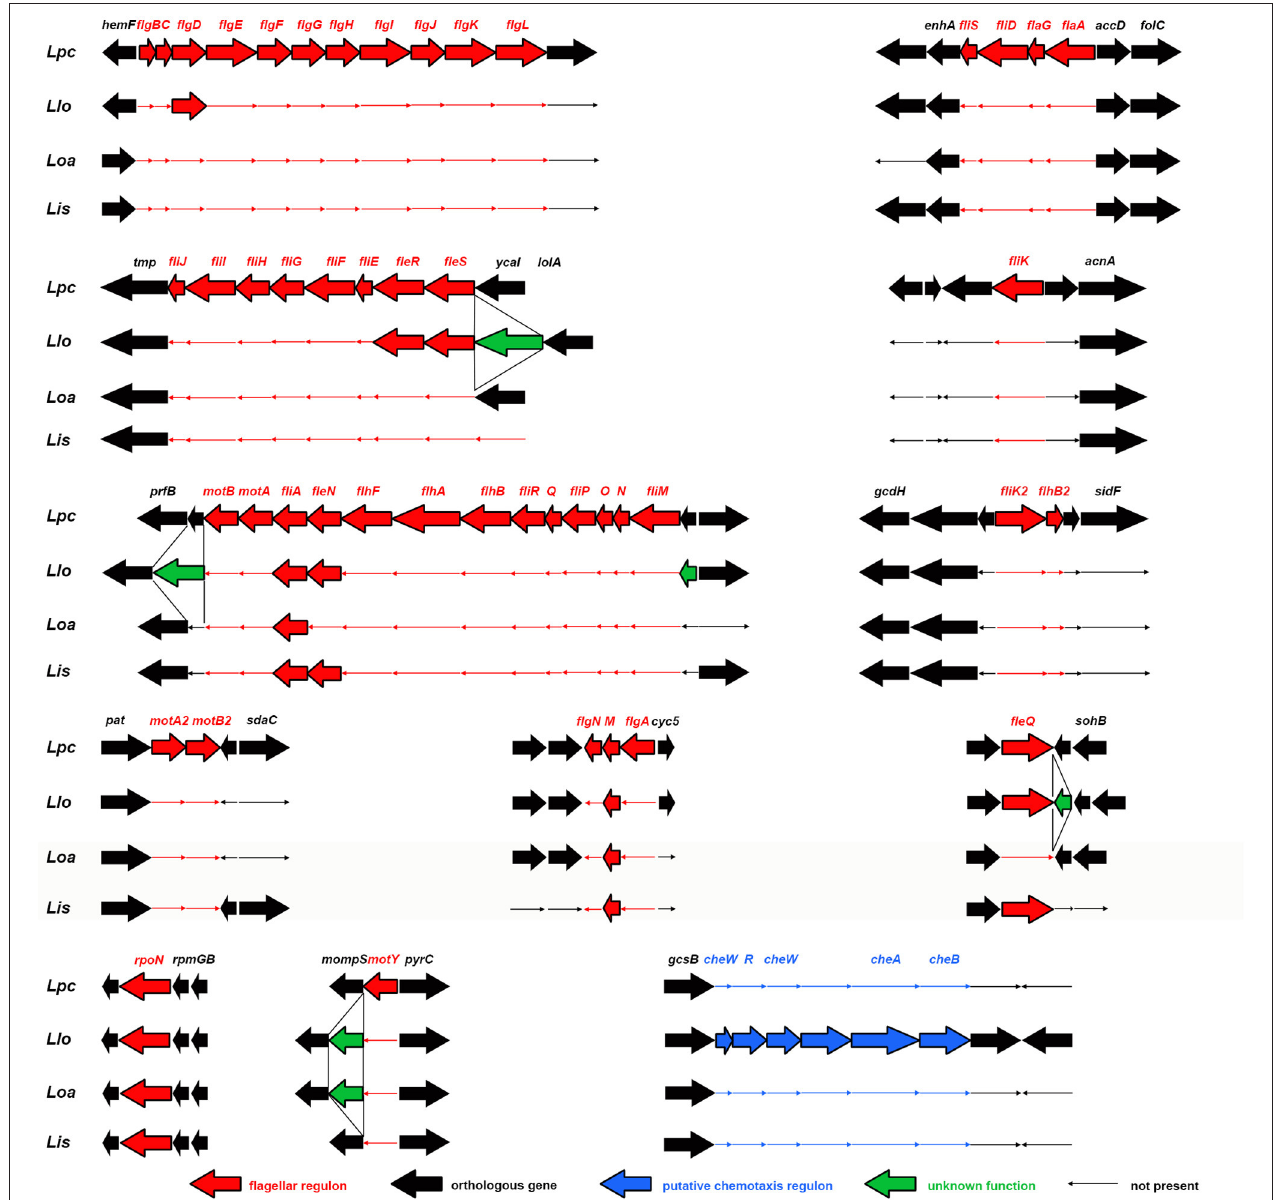
FIGURE 5 | Structure of the operons of the flagellar regulon of L. pneumophila Corby (Lpc), L. longbeachae (Llo), L. israeliensis (Lis), and L. oakridgensis (Loa). Genes are indicated by arrows and gene names are given above. Flagellar and chemotaxis genes are indicated in red and blue, respectively; other genes in black. Genes not present in a strain are indicated by thin arrows (Brzuszkiewicz et al., 2013,